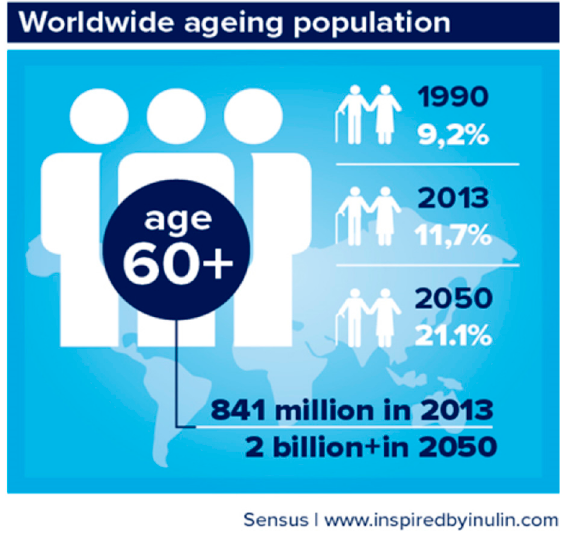
Figure 1. The aging population worldwide.